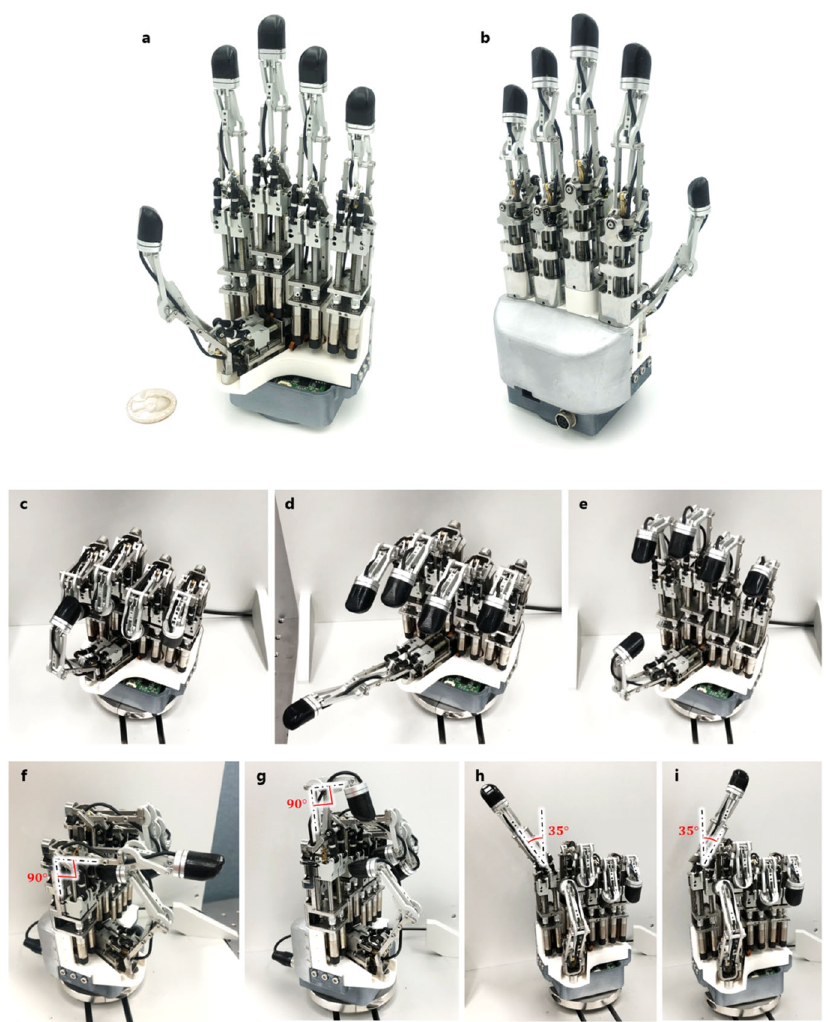
Fig. 5 Manufactured ILDA hand. a Front view. b Rear view. c – i Motion tests of the developed ILDA hand. c Fist of the hand. d , e Motions of the fi ve fi ngers of the hand. f – i Maximum 3-DOF motions of the fi nger.